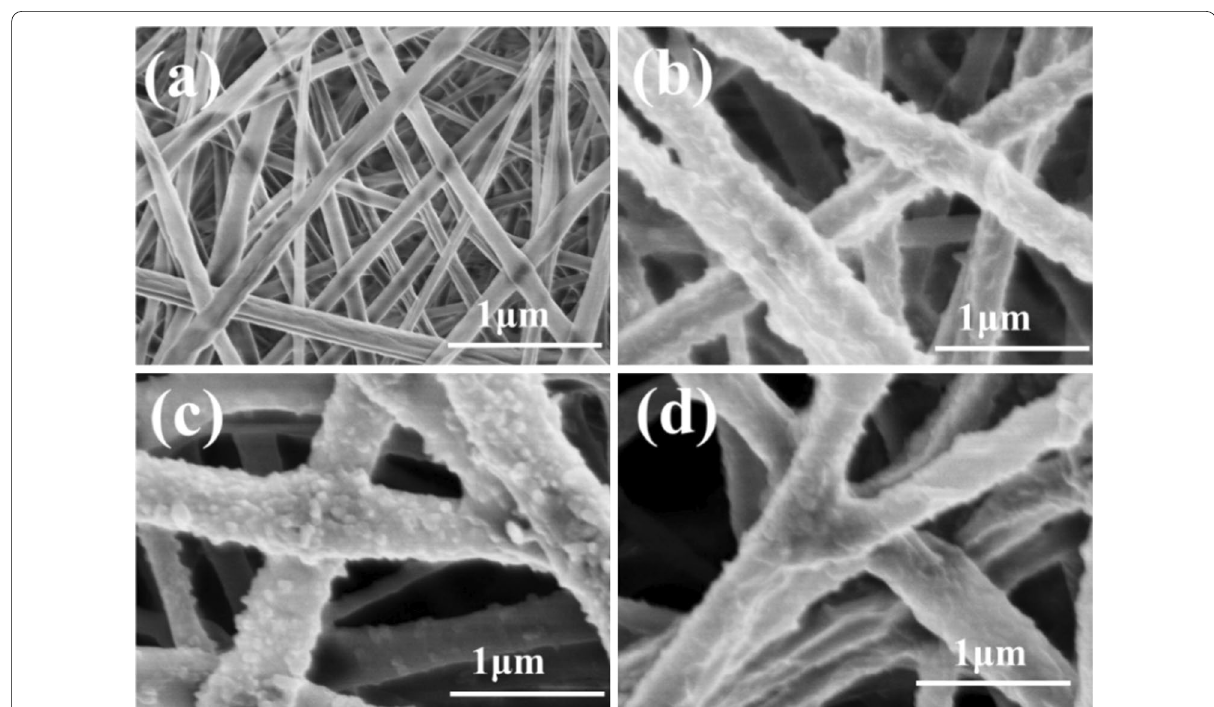
Fig. 3 Morphology of a PLA nanofibers, b PANI/PLA-HA, c PANI/PLA-SA, and d PANI/PLA-PA composite